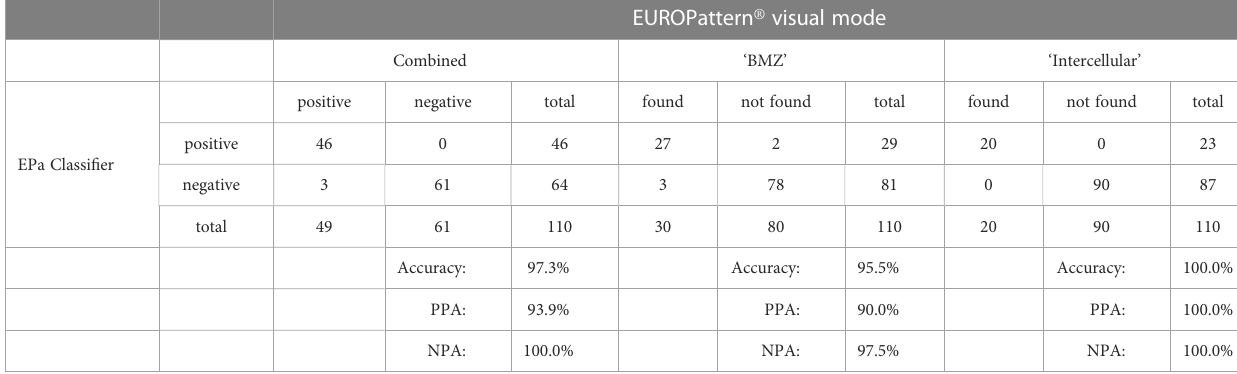
TABLE 2 Performance of the esophagus classi fi er (EPa-Classi fi er) compared to the conventional evaluation by an IIF